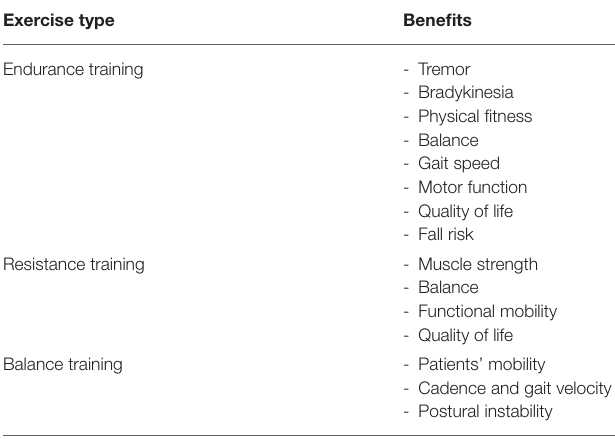
TABLE 1 | Positive results of the different types of exercise. Exercise